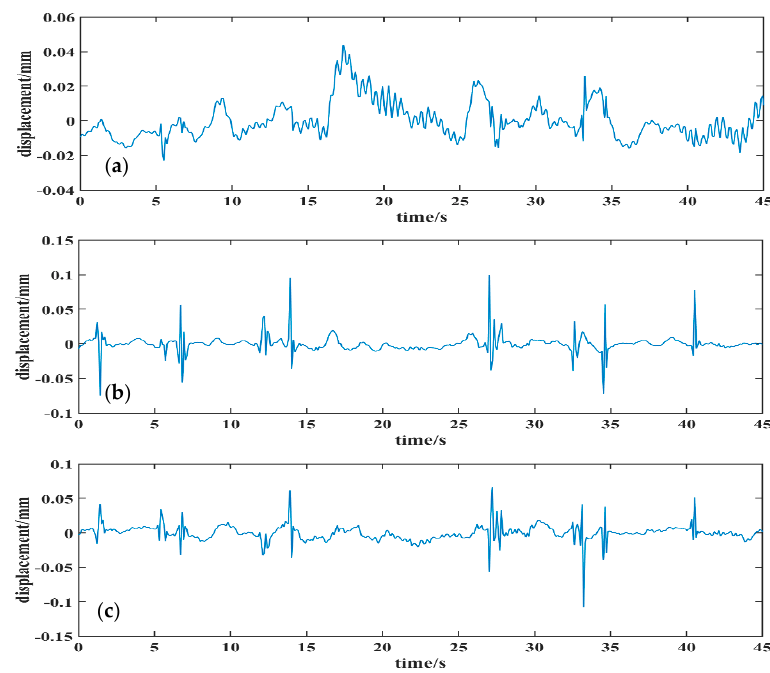
Figure 8. Three separated signal components found using the improved SOBI method. ( a ) Separated signal S1, ( b ) separated signal S2, and ( c ) separated signal S3.